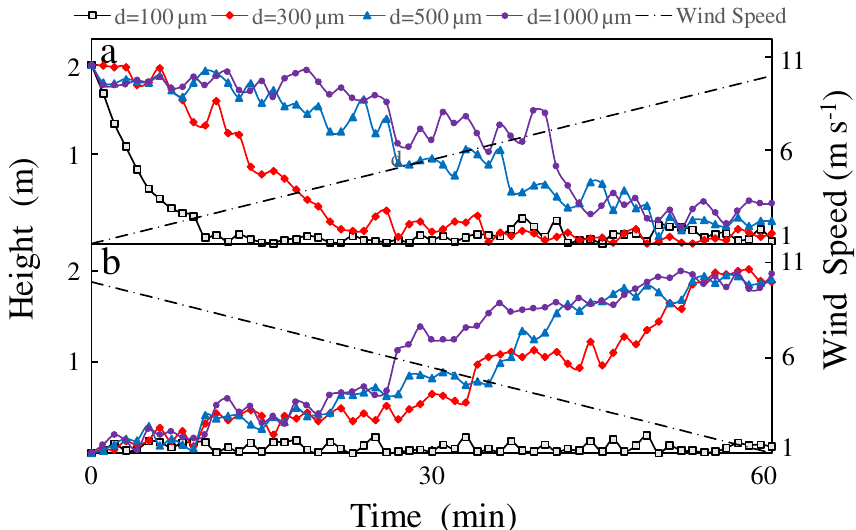
Figure 4. Vertical migration of Microcystis colonies under varying wind speeds: ( a ) simulations in which colonies were place on the water surface and ( b ) simulations in which colonies were placed at the base of the water column.